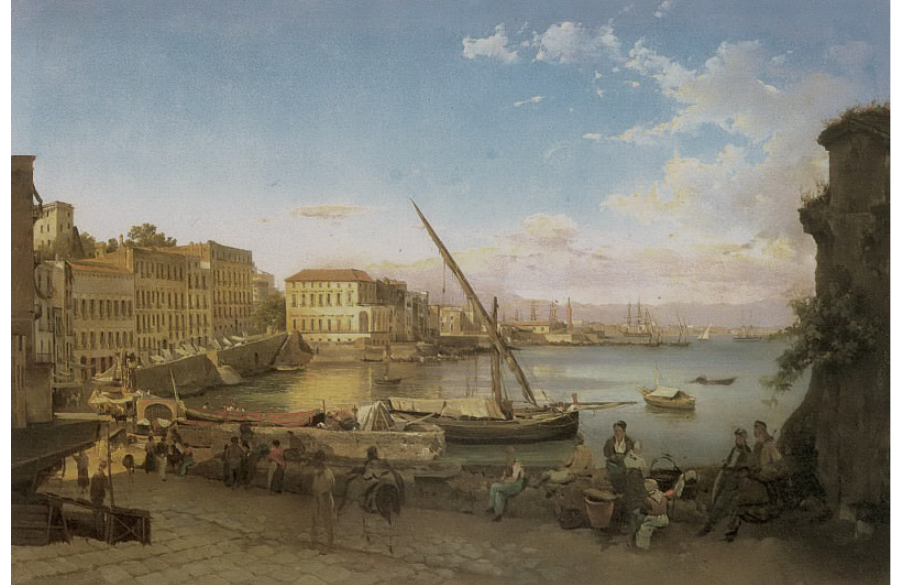
Figure 27. Sylvester Shchedrin. The Embankment of Santa Lucia , late 1820s. State Russian Museum, Saint Petersburg.